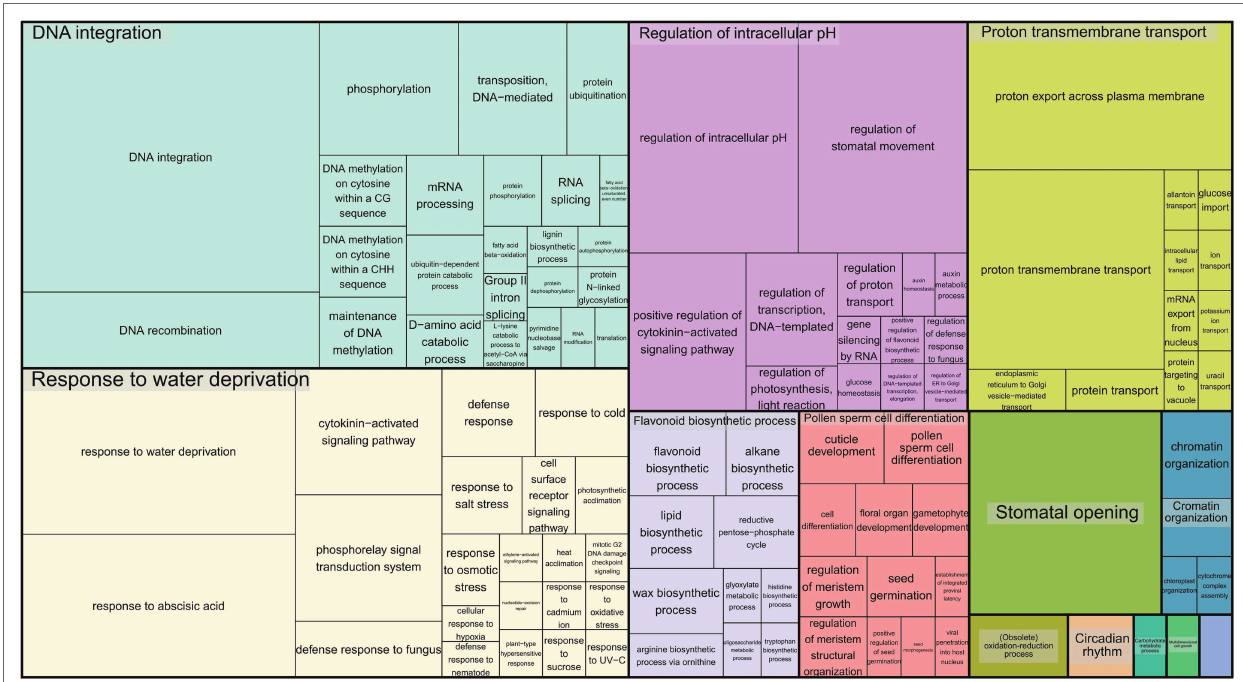
FIGURE 4 | Treemap representing the biological processes for the GO terms of the annotated